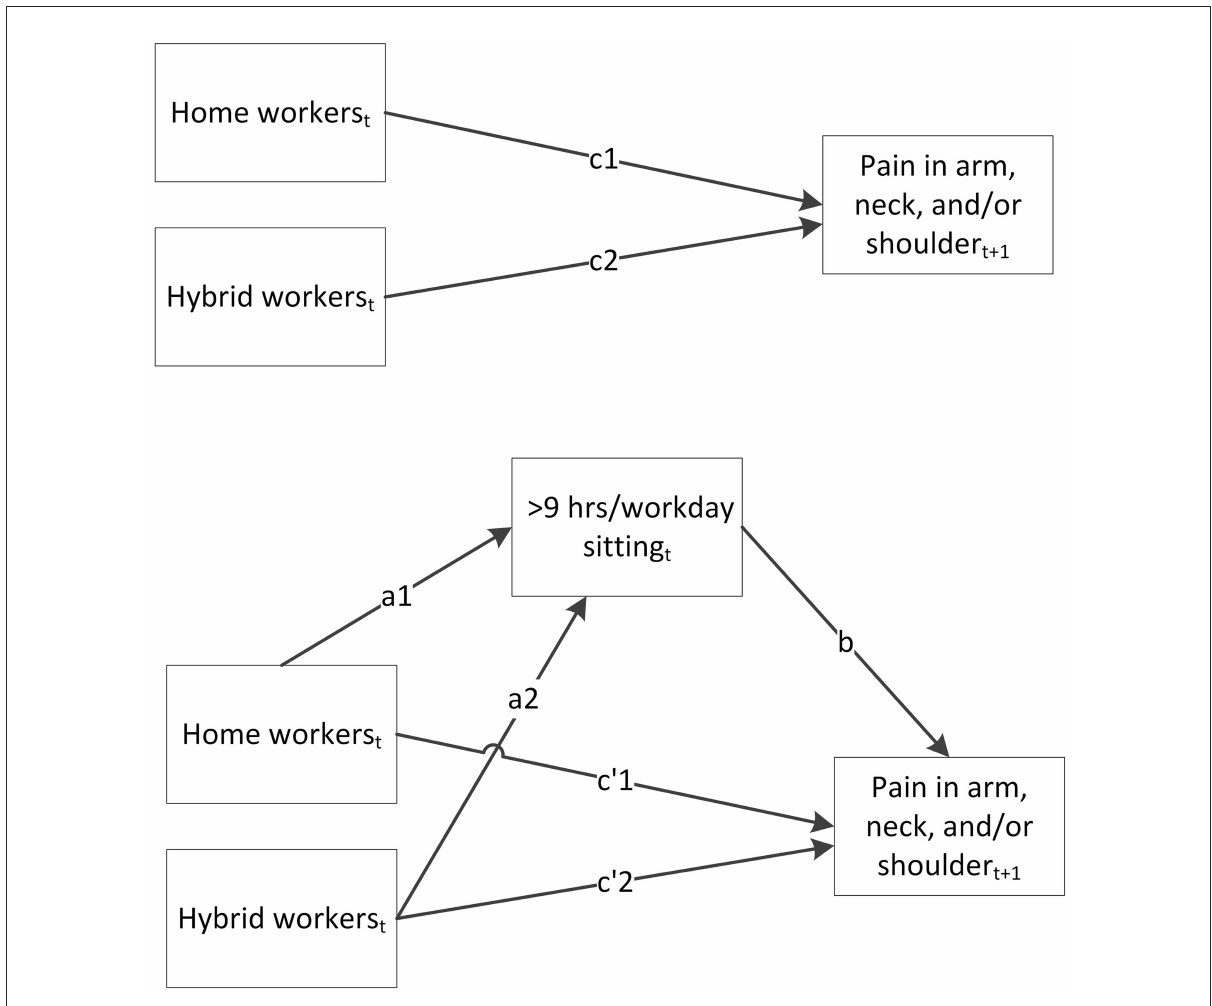
FIGURE1 Longitudinal mediation model of the total effect (c1 and c2) of work situation measured in round t on pain in the arm, neck, and/or shoulder measured in round t + 1, the indirect effect of sedentary behavior measured in round t (a1*b and a2*b), and the direct effect (c’1 and c’2) of work situation on pain in the arm, neck, and/or